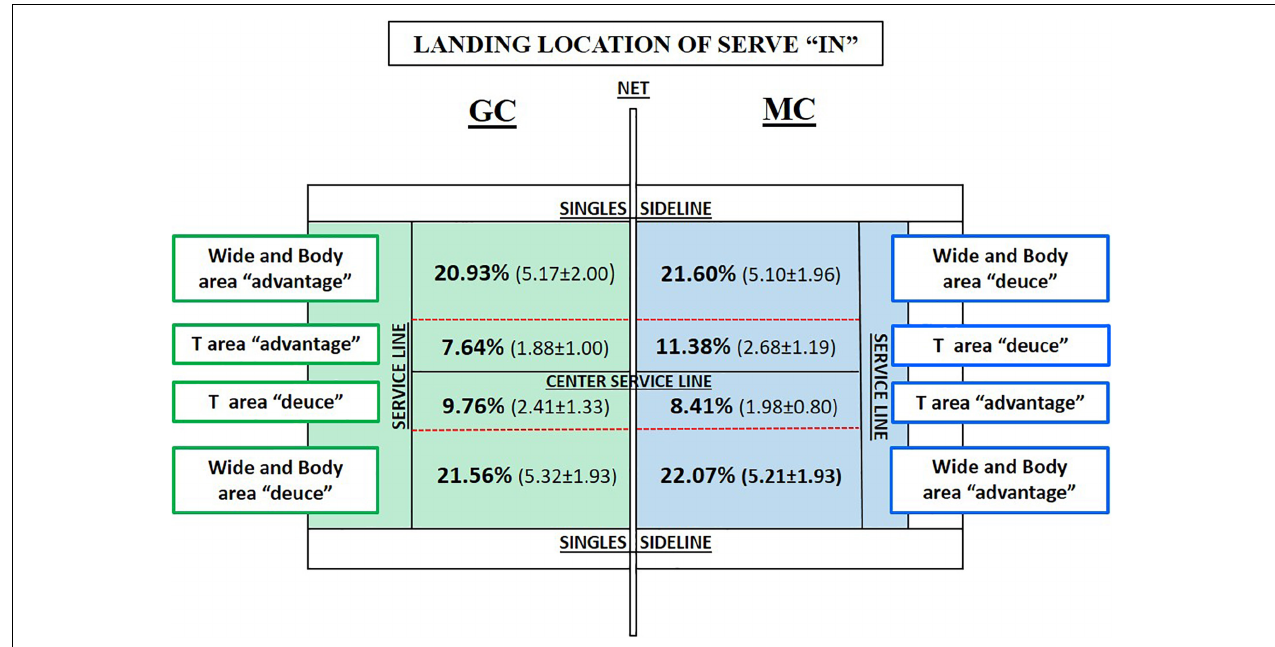
FIGURE 3 | Percentage and mean of the landing locations of the serve “in” per match in both competitions (Tennis 10s Green Competition “GC” = green color and Modified Competition “MC” = blue